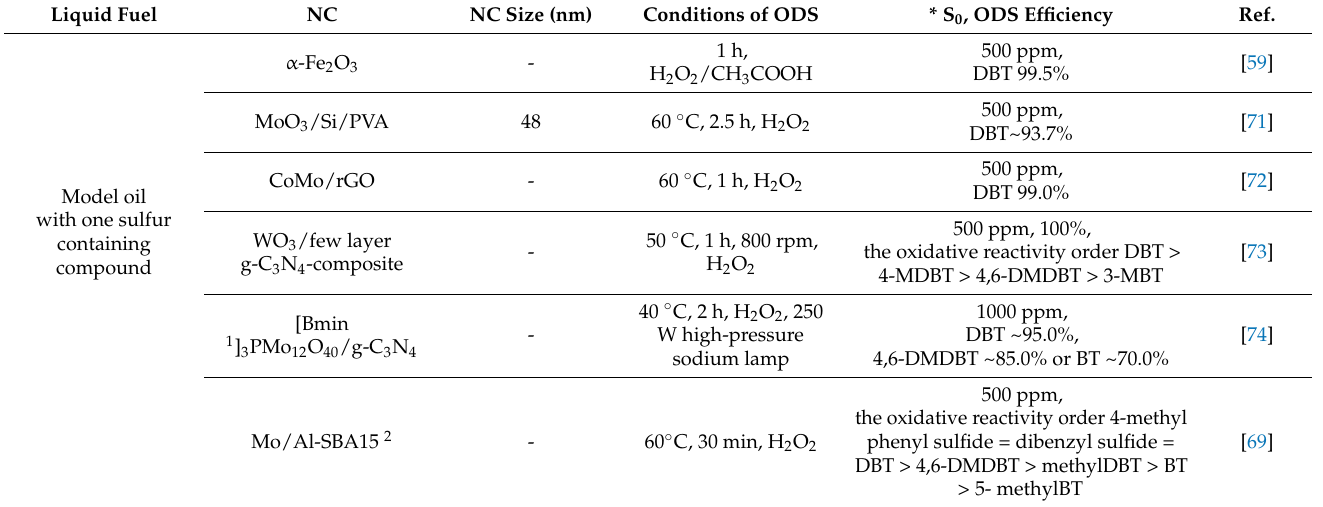
Table 2. Examples of NCs used for ODS of model oil and real liquid fuels. Liquid